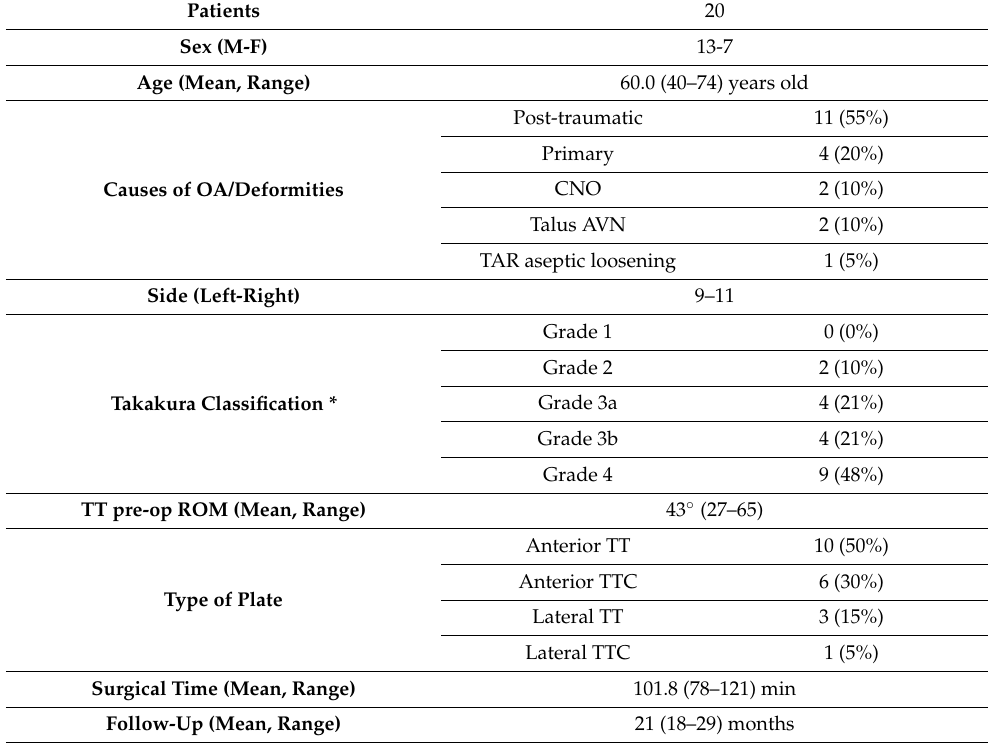
Table 1. Demographic characteristics of the patients.